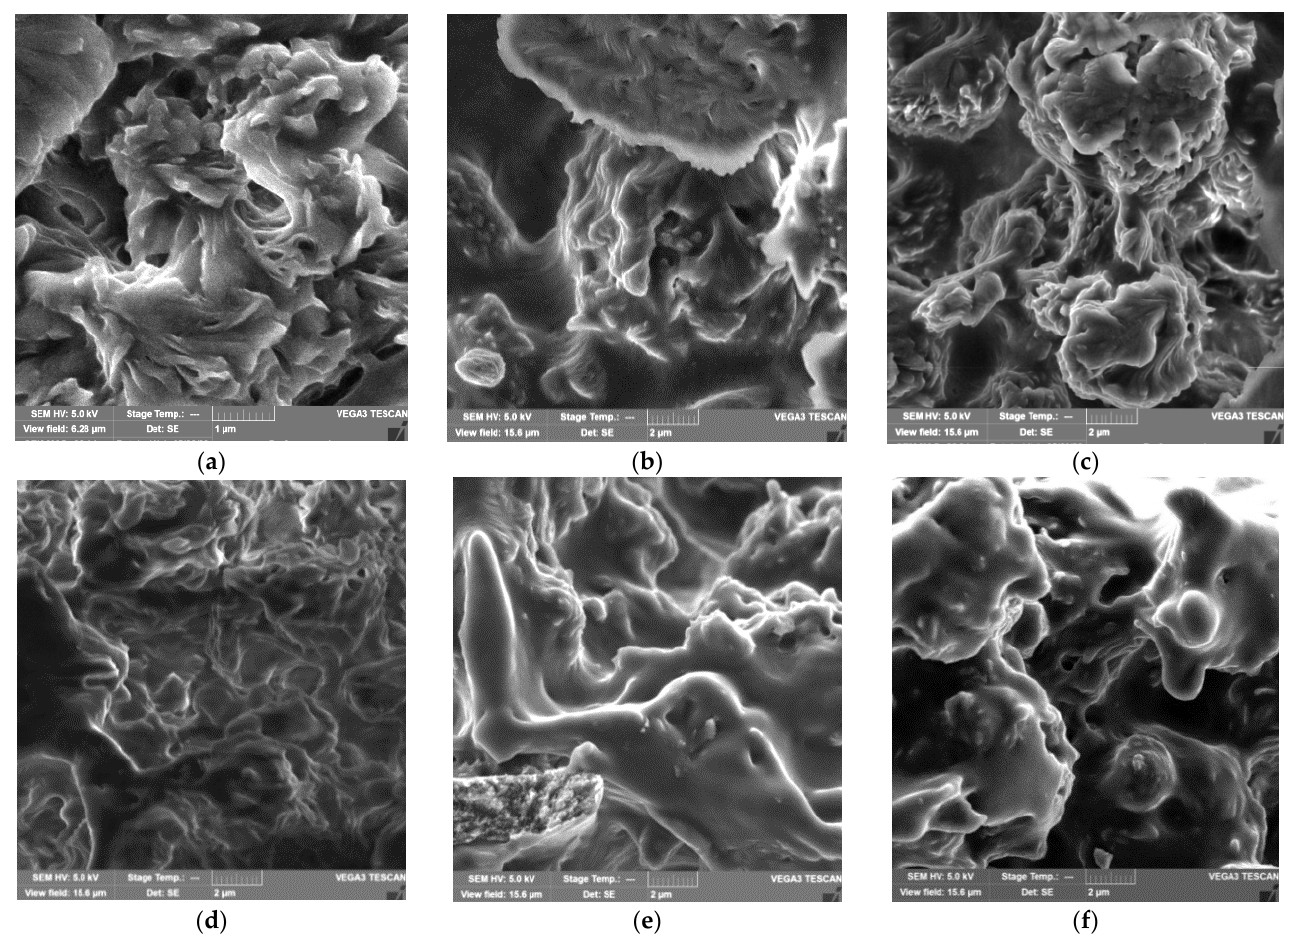
Figure 2. SEM images of the surface ( a – c ) and cleavage ( d – f ) of the PHBV/PCL/CNC composite films: PHBV/PCL(1:1)/CNC(PVP)–5 ( a , d ); PHBV/PCL(1:1)/CNC(PVP)–10 ( b , e ); PHBV/PCL(1:1)/CNC(PVP)-15 ( c , f ). The scale is 1 µ m ( a ); 2 µ m ( b – f ).